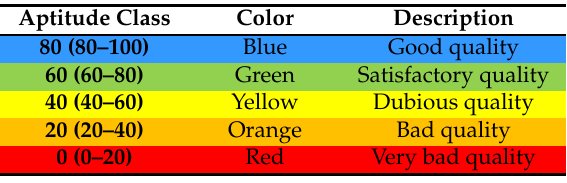
Table 2. Water quality index classes and